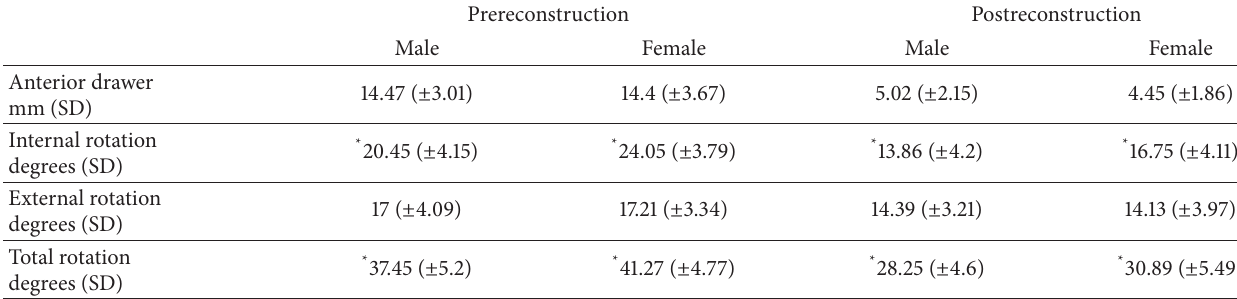
Table 3: Gender differences pre- and postreconstruction.